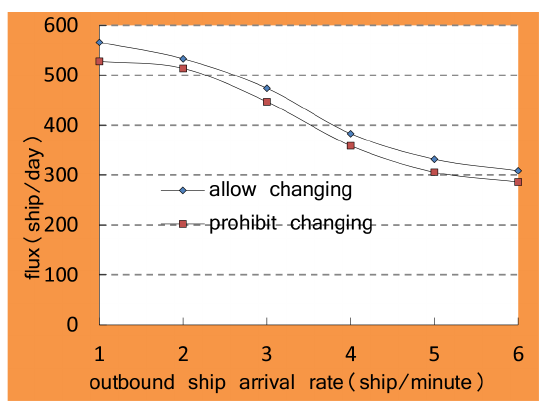
Figure 15. Traffic flux of waterway system and ship arrival rate as a function (inbound ship arrival rate = 4)